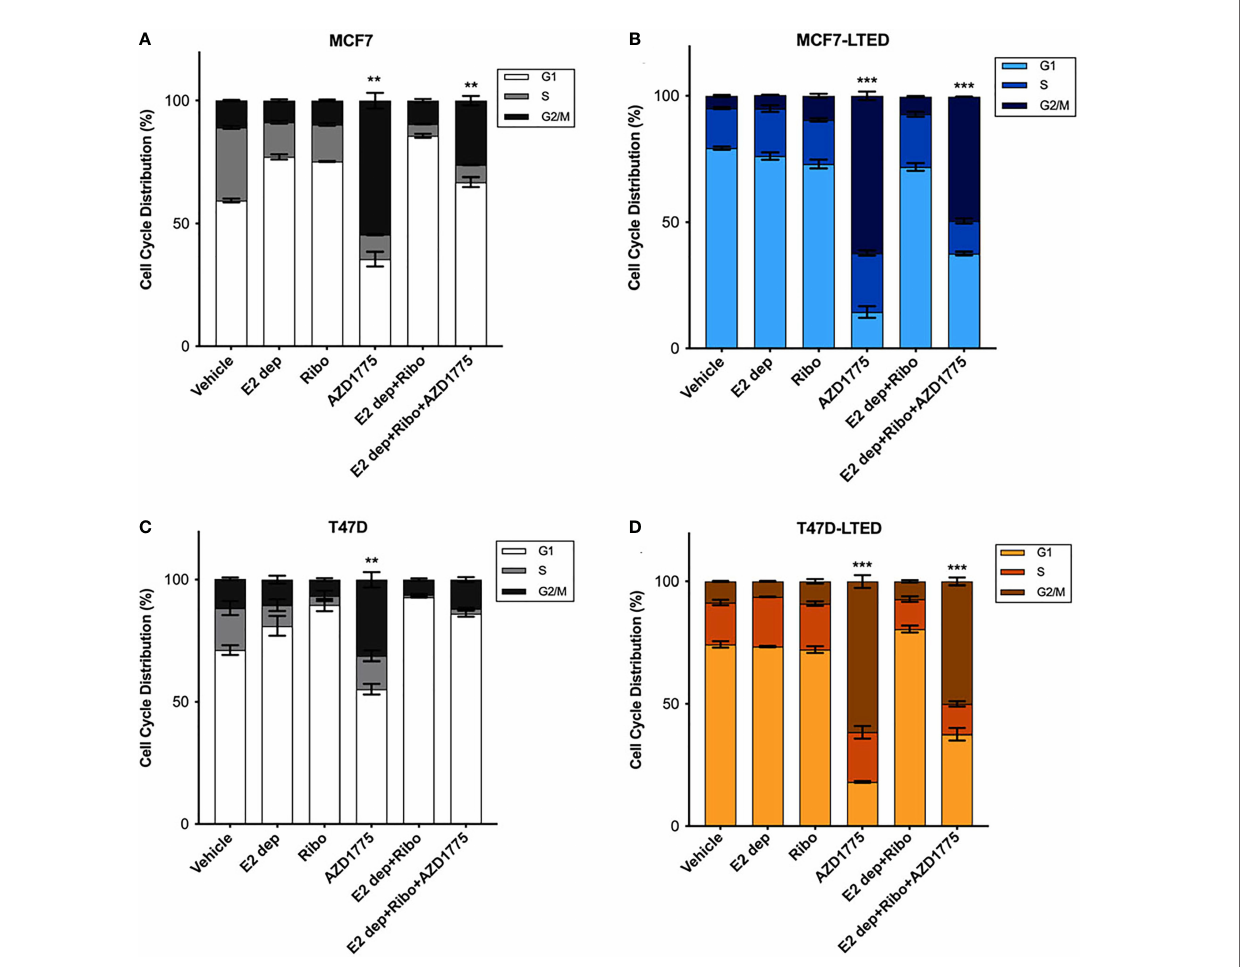
FIGURE 7 | Inhibition of WEE1 with AZD1775 increased G2/M cell cycle arrest in LTED cells. (A – D) MCF7 and T47D and their LTED derivatives were treated with vehicle, E2 deprivation (E2 dep), 500nM ribociclib (ribo), 500nM AZD1775, combination of E2 dep and ribo or the combination of E2 dep, ribo and AZD1775 for 6 days. Cell cycle pro fi les under different treatment conditions were analyzed by fl uorescence-activated cell sorting (FACS) and compared to vehicle treated cells. Results are reported as mean percent cell cycle distribution + SE **p < 0.01 and ***p < 0.001 (ANOVA) for % cell in G2/M phase for indicated treatment conditions compared with vehicle control in respective cell lines. Bar graphs represent data from three independent experiments